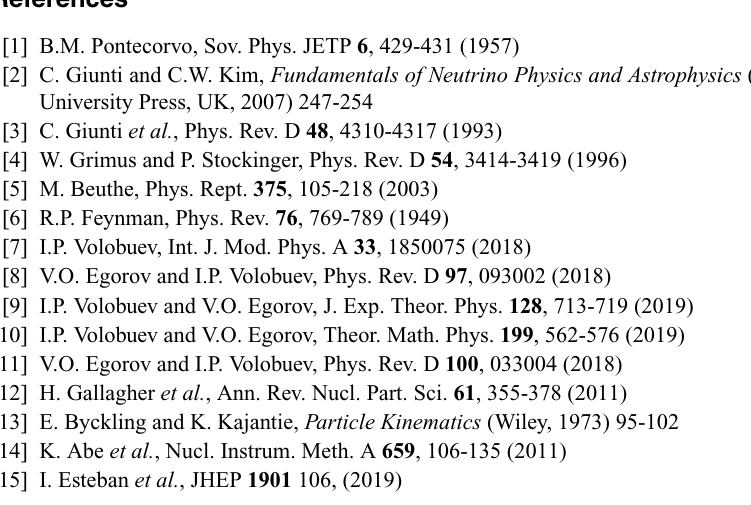
experiments with the neutrinos propagating in the direction at an angle to the axis of the ini- tial particle beam simply and naturally. The obtained results confirm that the position of the far detector in the T2K experiment corresponds to the first oscillation maximum for electron production processes and the first oscillation minimum for muon production processes. The developed formalism also allows one to describe the neutrino oscillation fading out, which arises due to the spread of momenta of decaying π - and K